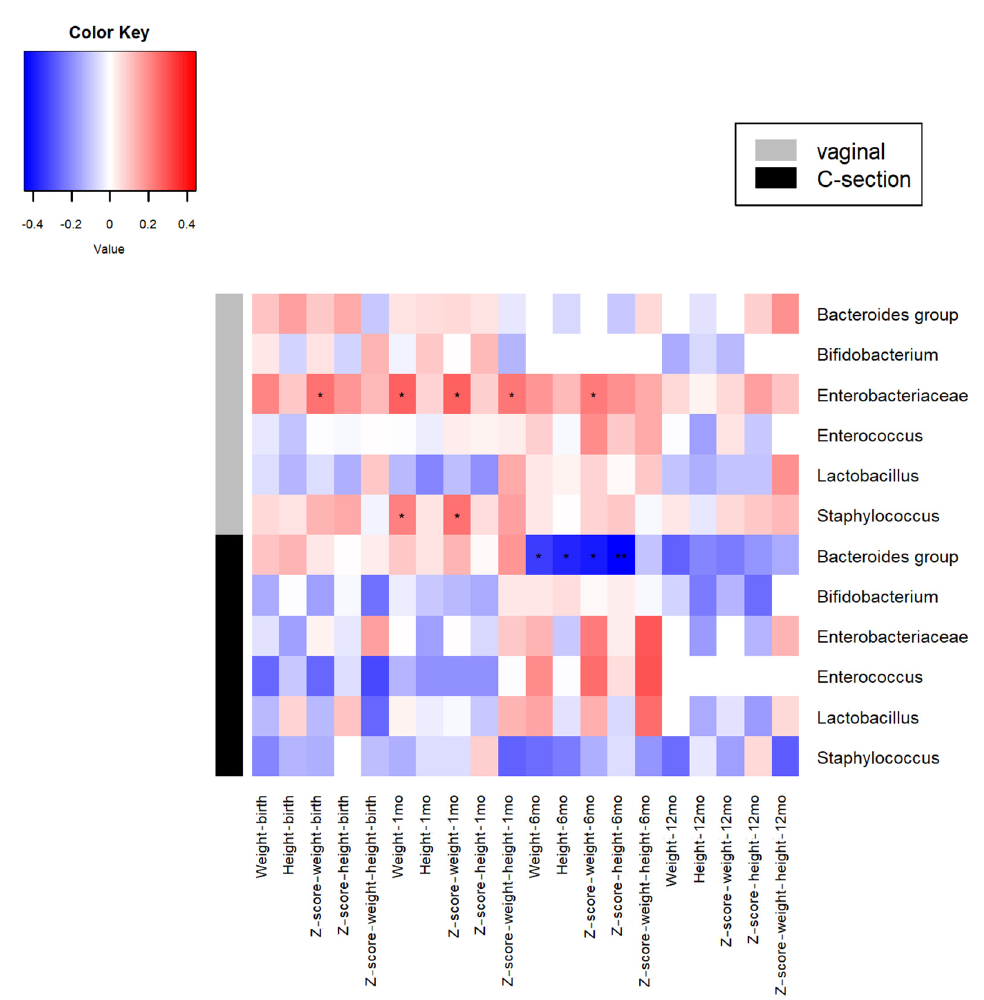
Figure 1. Heatmap showing the pairwise Pearson correlation coefficients between microbial groups at 1 month of age and the analyzed growth variables for both vaginally delivered and C-section-delivered babies. * p < 0.05.